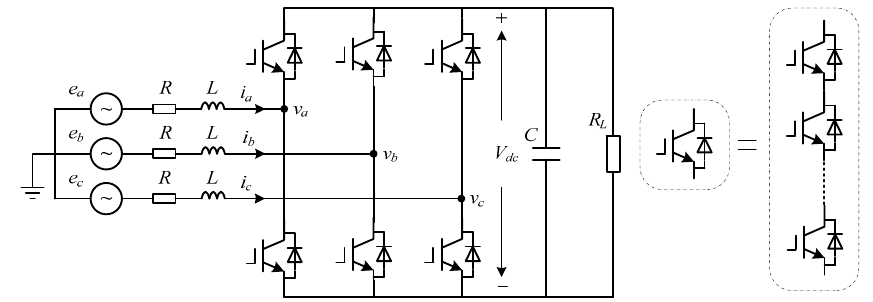
Figure 2. Schematic of three-phase VSC for each converter station.